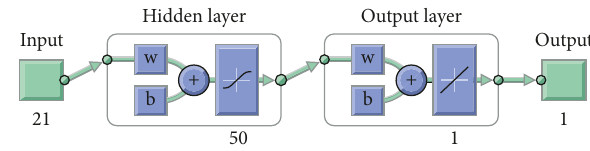
Figure 3: Flow chart of the prediction